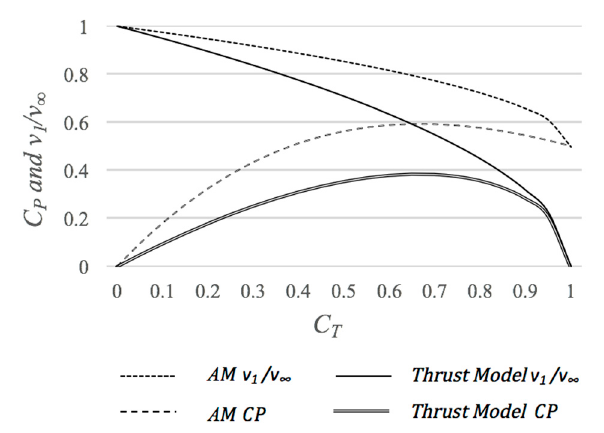
Figure 12. Thrust Model and General AM prediction of C P and velocity ratio ( v 1 / v ∞ ) in a tube ( β = 1).